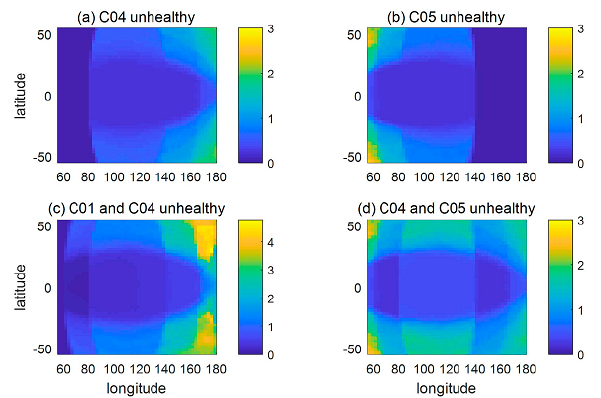
Figure 11. PDOP increments in the service area.